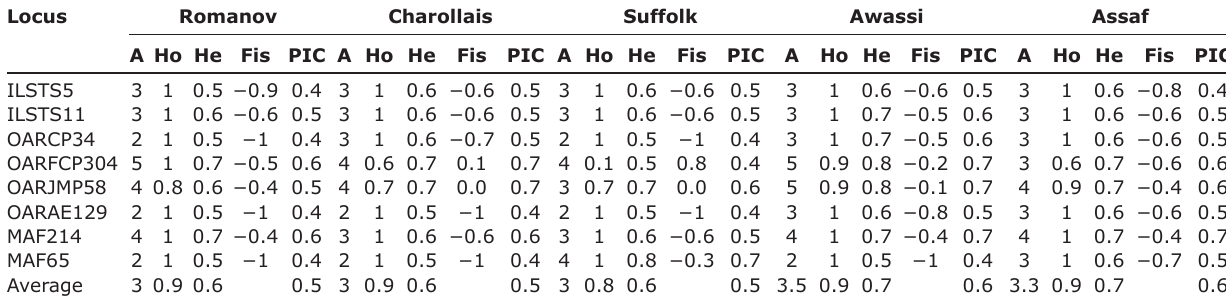
Table-3: Number of alleles (A), observed (Ho), and expected He, Fi as a measure of heterozygote deficiency or excess, and polymorphic information contents (PIC) for eight microsatellites in Romanov, Charollais, and Suffolk, Awassi, and Assaf sheep breeds. Locus Romanov Charollais Suffolk